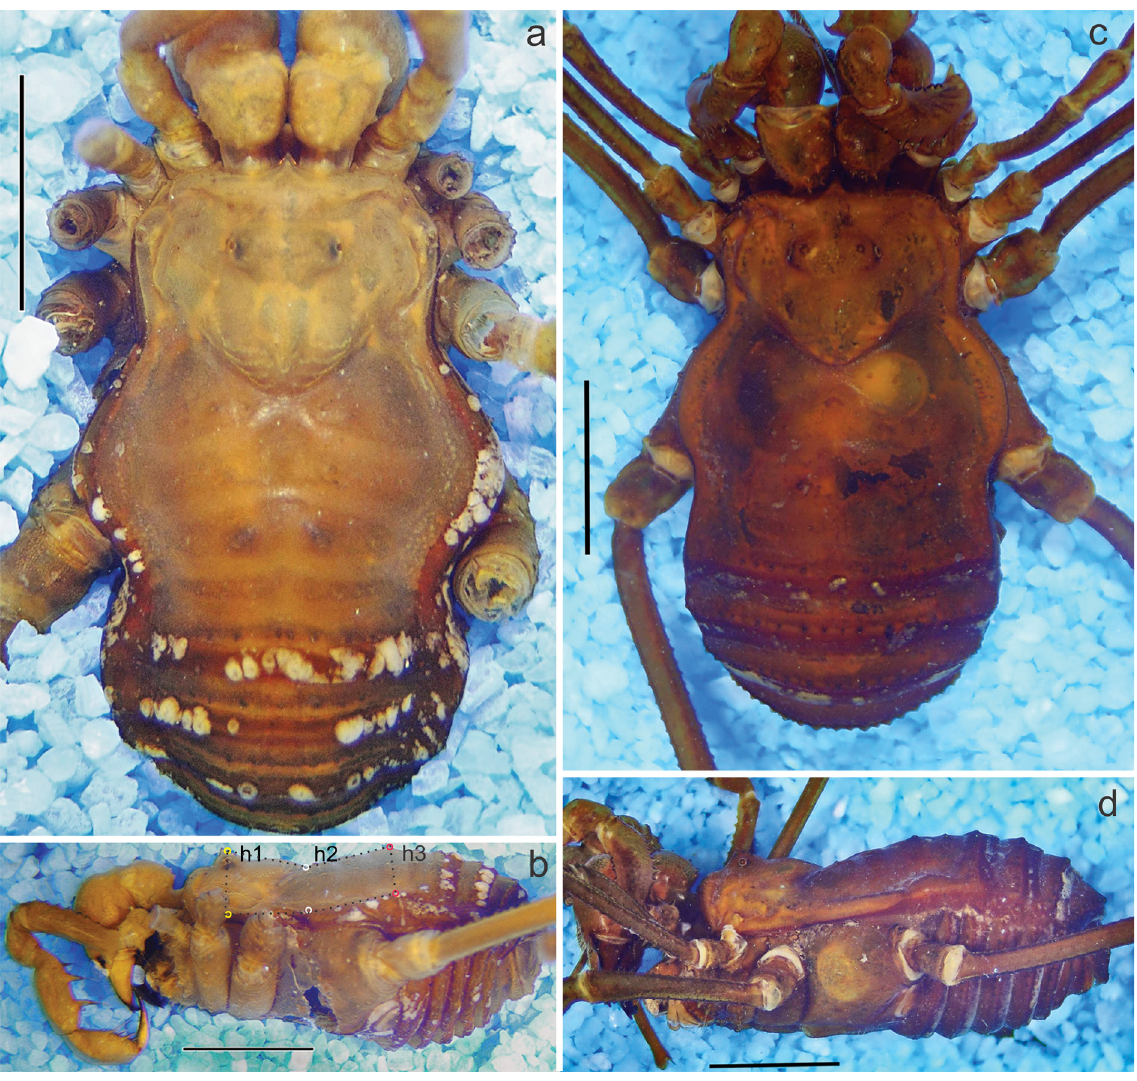
Fig. 2. Phalangodus anacosmetus Gervais, 1842 (syntypes of Allocranaus giganteus Mello-Leitão, 1940, MNRJ 00126). a–b . ♂, juvenile. a . Habitus, dorsal view. b . Habitus, lateral view. c–d . ♀. c . Habitus, dorsal view. d . Habitus, lateral view. Scale bars = 5 mm. Abbreviations: see Material and